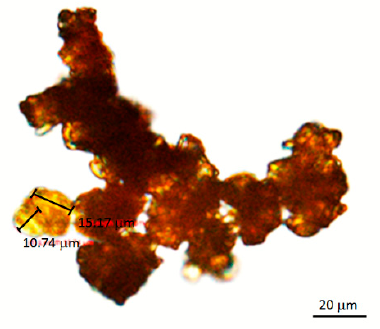
Figure 7. Rhein crystal observed under a light microscope (magnification 20 × ).